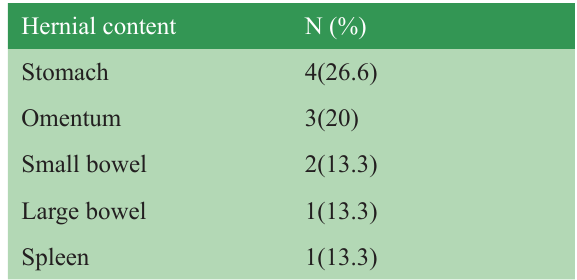
Table 4: Hernial